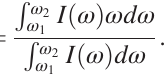
FIG. 4. Temperature dependence of the integrated RIXS intensity I and 2 – 3.5 eV, respectively. The dashed lines indicate T value (0.25, 0.25). (a),(d) Underdoped Bi-2212 ( T ¼ 70 Bi-2212 ( T c